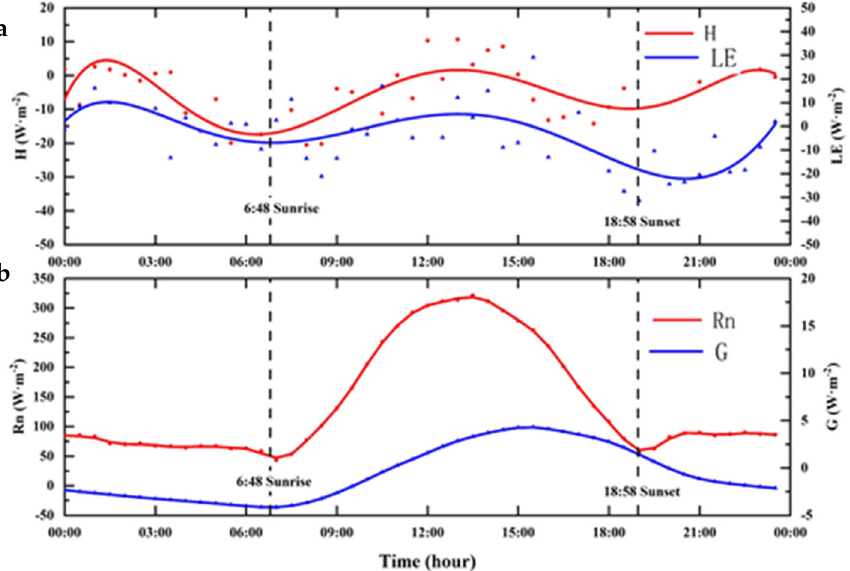
Figure 7. Characteristics of hourly energy flux. ( a ) H represents sensible heat flux; ( b ) LE represents latent heat flux, Rn represents net radiation, G represents soil heat flux.